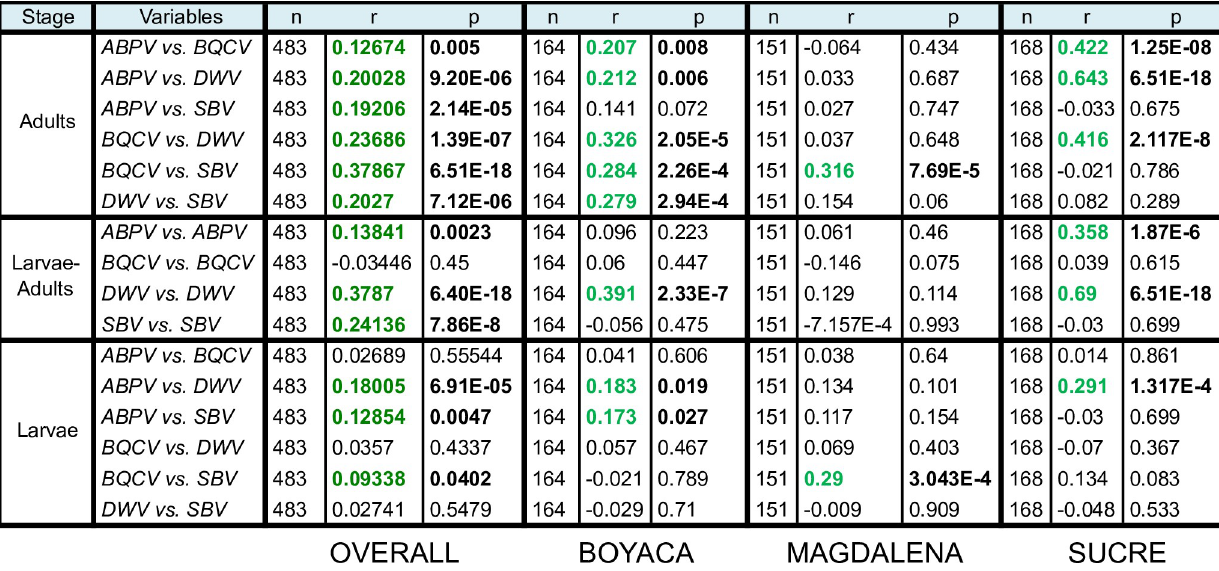
Fig 6. Pairwise Spearman rank correlations among viral prevalence in adults and larvae. Significant differences (p < 0.05) are represented in bold case. Positive correlations are highlighted in green.